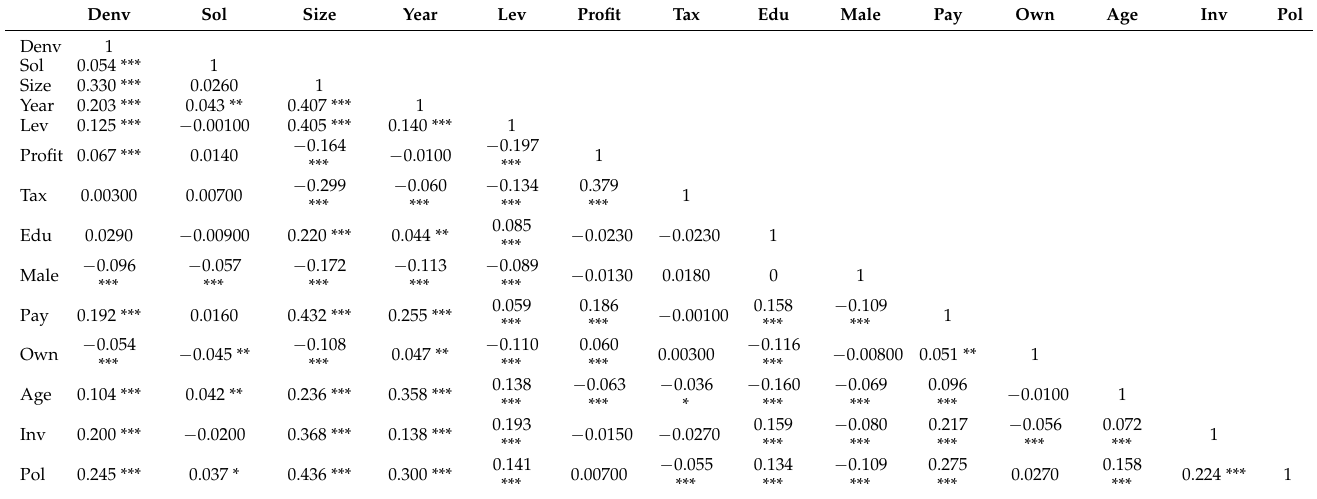
Table A1. Pearson correlation matrix of the dependent variable Denv